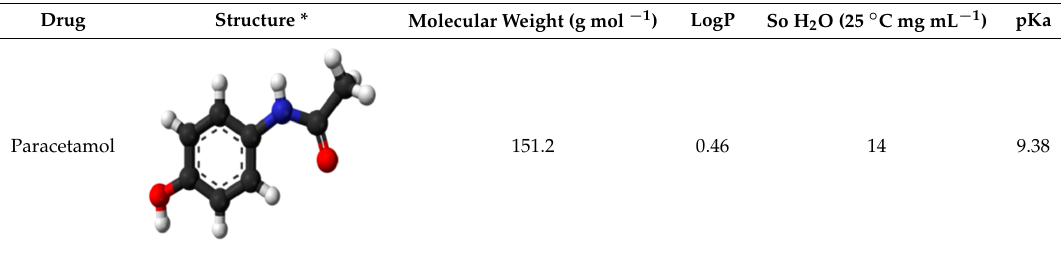
Table 1. Physicochemical properties of paracetamol.